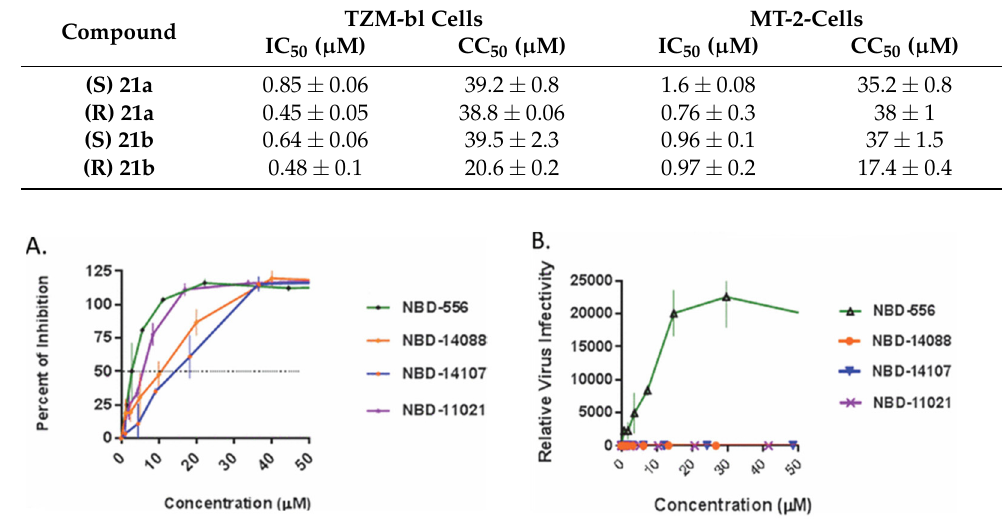
Figure 3. ( A ) Inhibition assay of tested compounds (R) 21a and (S) 21b with the controls NBD-556 and NBD-11021. ( B ) Infectivity assay of the compounds and controls with CD4-dependent HIV-1 ADA [29]. Table 3. The SAR study of the compounds against HIV-1 in TZM-bl and MT-2 cells [29]. Compound